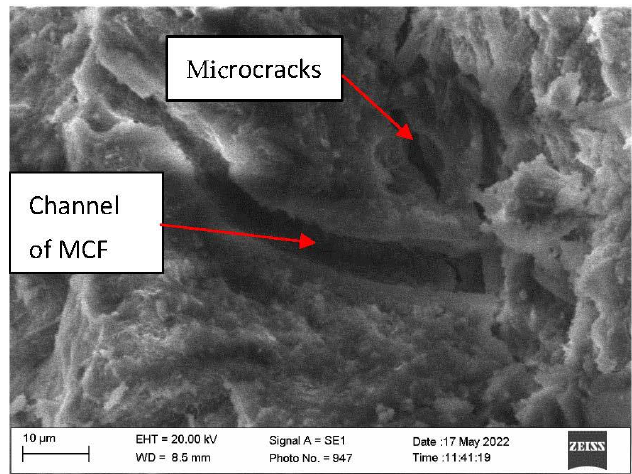
Figure 10. Microstructure of the sample AP100 after fire exposure.